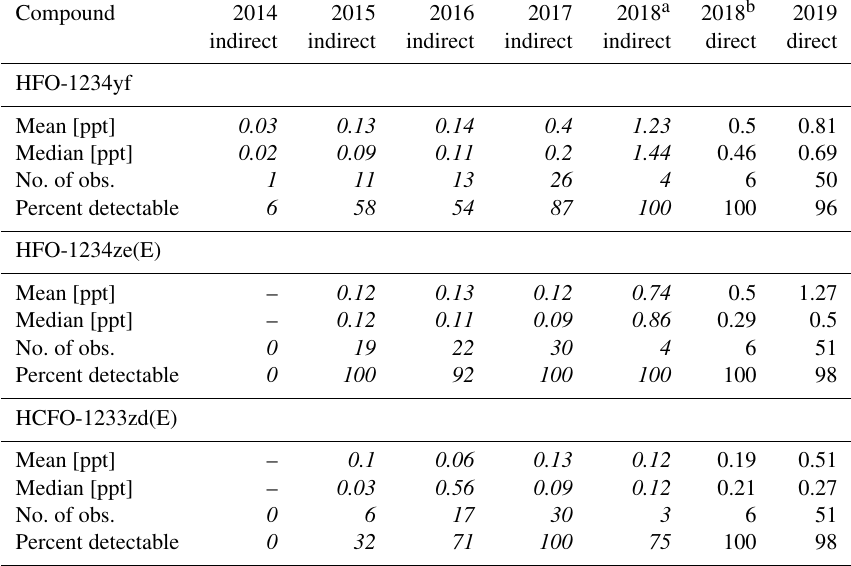
a Data of 2018 are calculated indirectly until 23 October. b Data of 2018 are calculated directly since 24 October, using the calibration standard GUF-16.